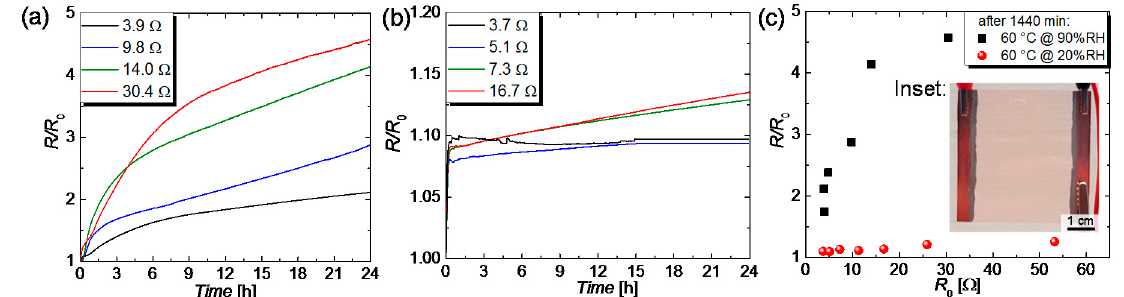
Figure 9. R / R 0 plotted as a function of time for CuNW heaters with different R 0 that were subjected to different moisture levels of ( a ) 90%RH and ( b ) 20%RH, at a temperature of 60 °C and for a duration of 24 h. ( c ) R / R 0 as a function of R 0 for the two moisture levels. The inset shows a photo for a CuNW film.